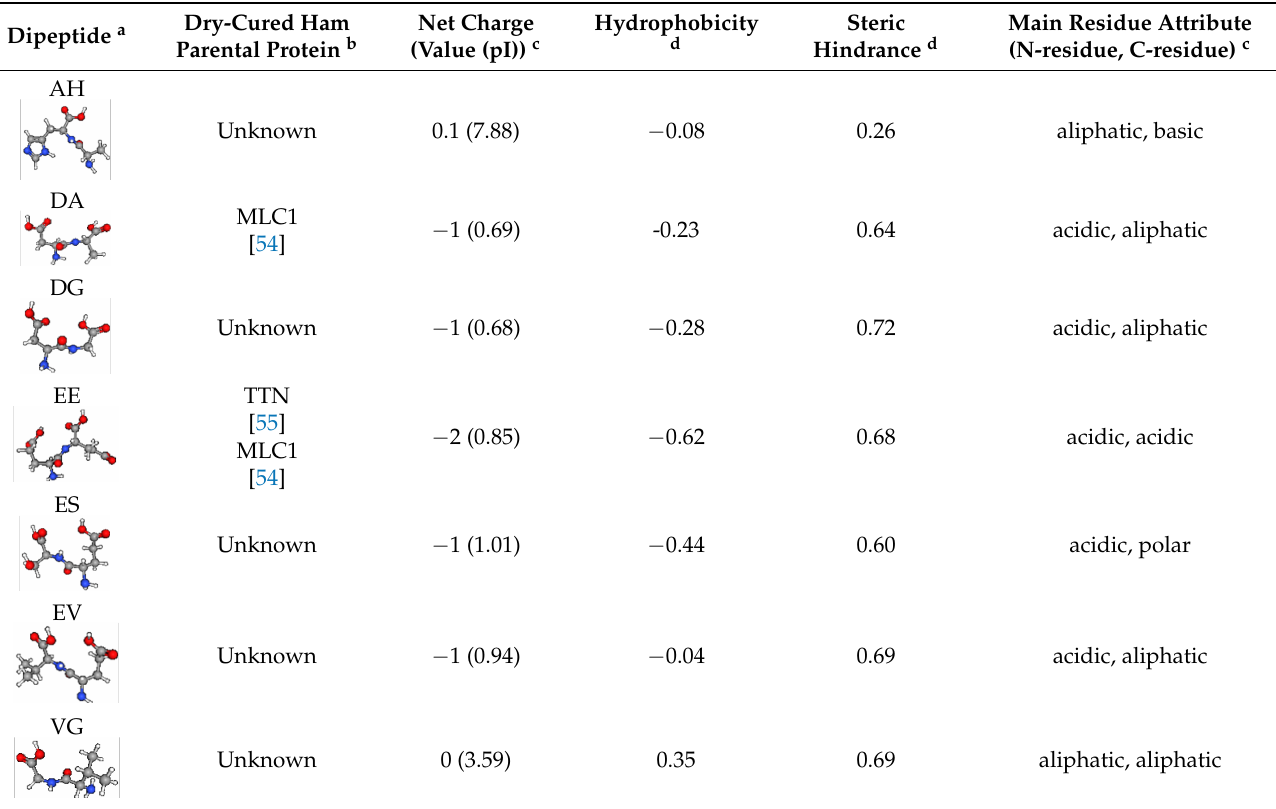
Table 1. Main physicochemical characteristics attributed to the dipeptides under